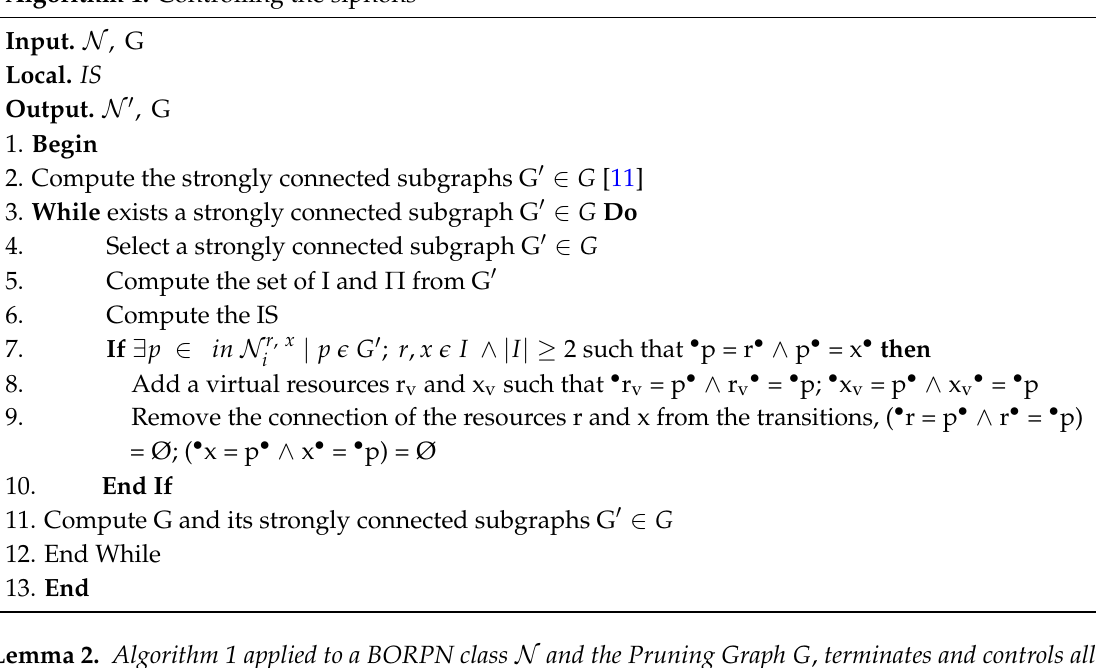
Algorithm 1. Controlling the